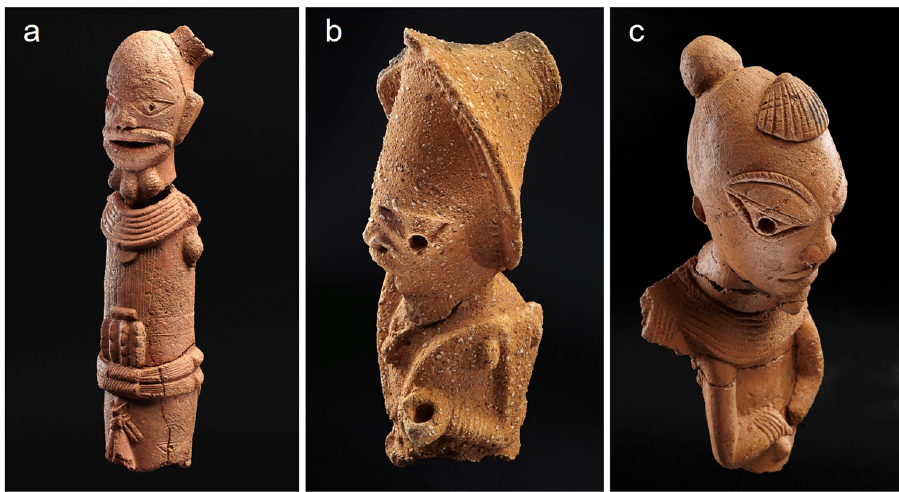
Fig. 2 Nok culture terracotta statues. Composite of Nok culture terracottas from three sites: a Ifana, b Ungwar Kura and c Pangwari (© Goethe University, Frankfurt).